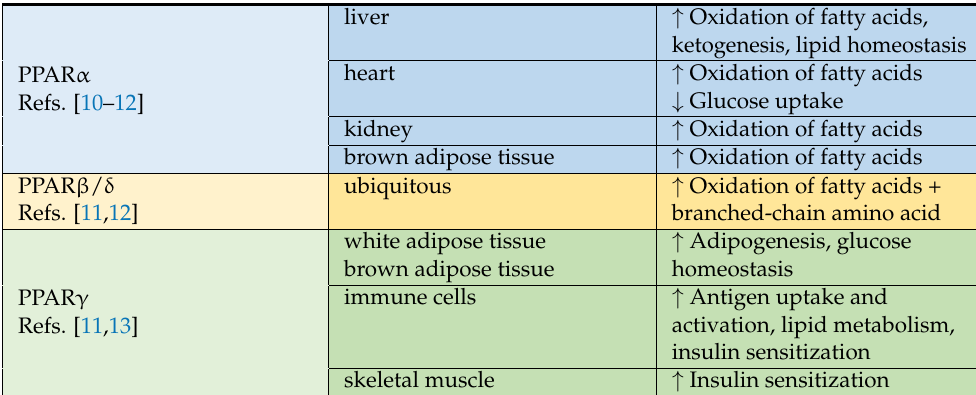
Table 1. Tissue distribution and functions of peroxisome proliferator-activated receptors (PPARs) in lipid and carbohydrate metabolisms. liver ↑ Oxidation of fatty acids, ketogenesis, lipid homeostasis heart ↑ Oxidation of fatty acids ↓ Glucose